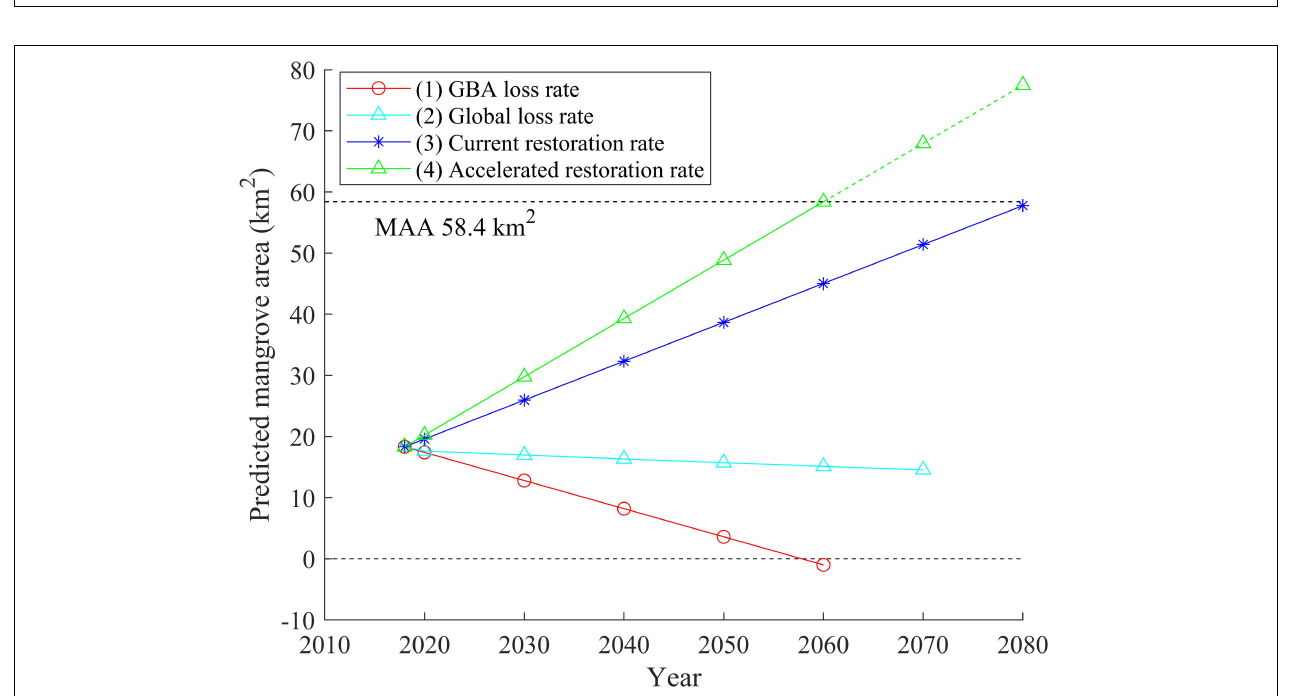
FIGURE 6 | Prediction of mangrove dynamics under four scenarios: (1) mangrove loss in the rate as observed between 1990 and 2000 in this study; (2) mangrove loss in the global loss rate as observed in the 20th century; (3) mangrove restoration in the current rate including forests from both human afforestation and natural establishment; and (4) mangrove expansion in the accelerated restoration rate. The upper dashed line shows the maximal afforestation area (MAA = 58.4 km 2 ), which is the sum of saltmarsh, tidal flat, and water areas in 2018.